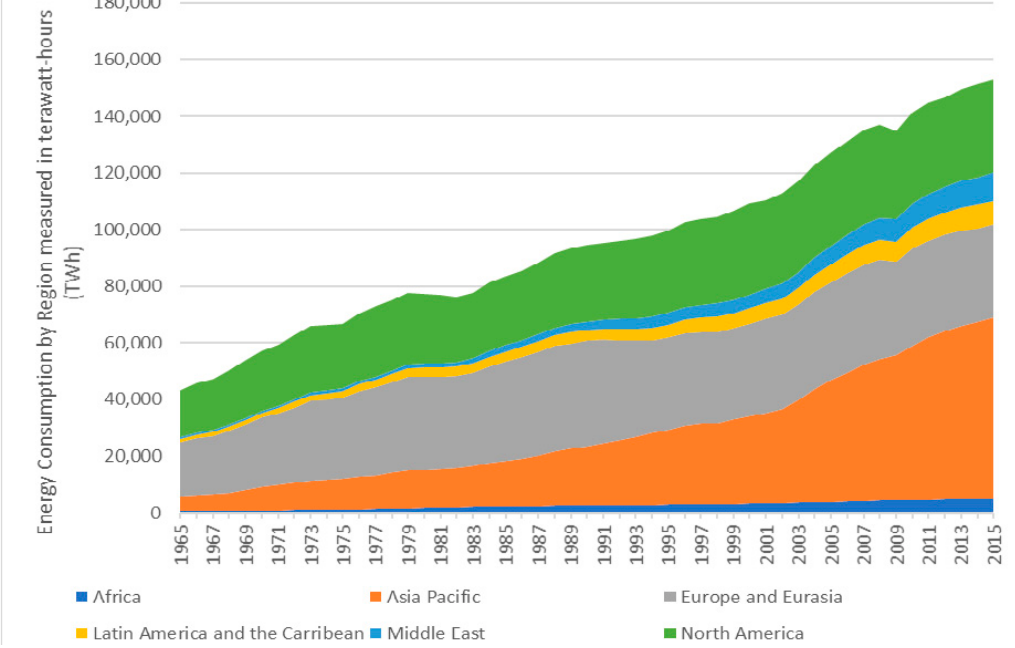
Figure 5. Global energy consumption by region [19].